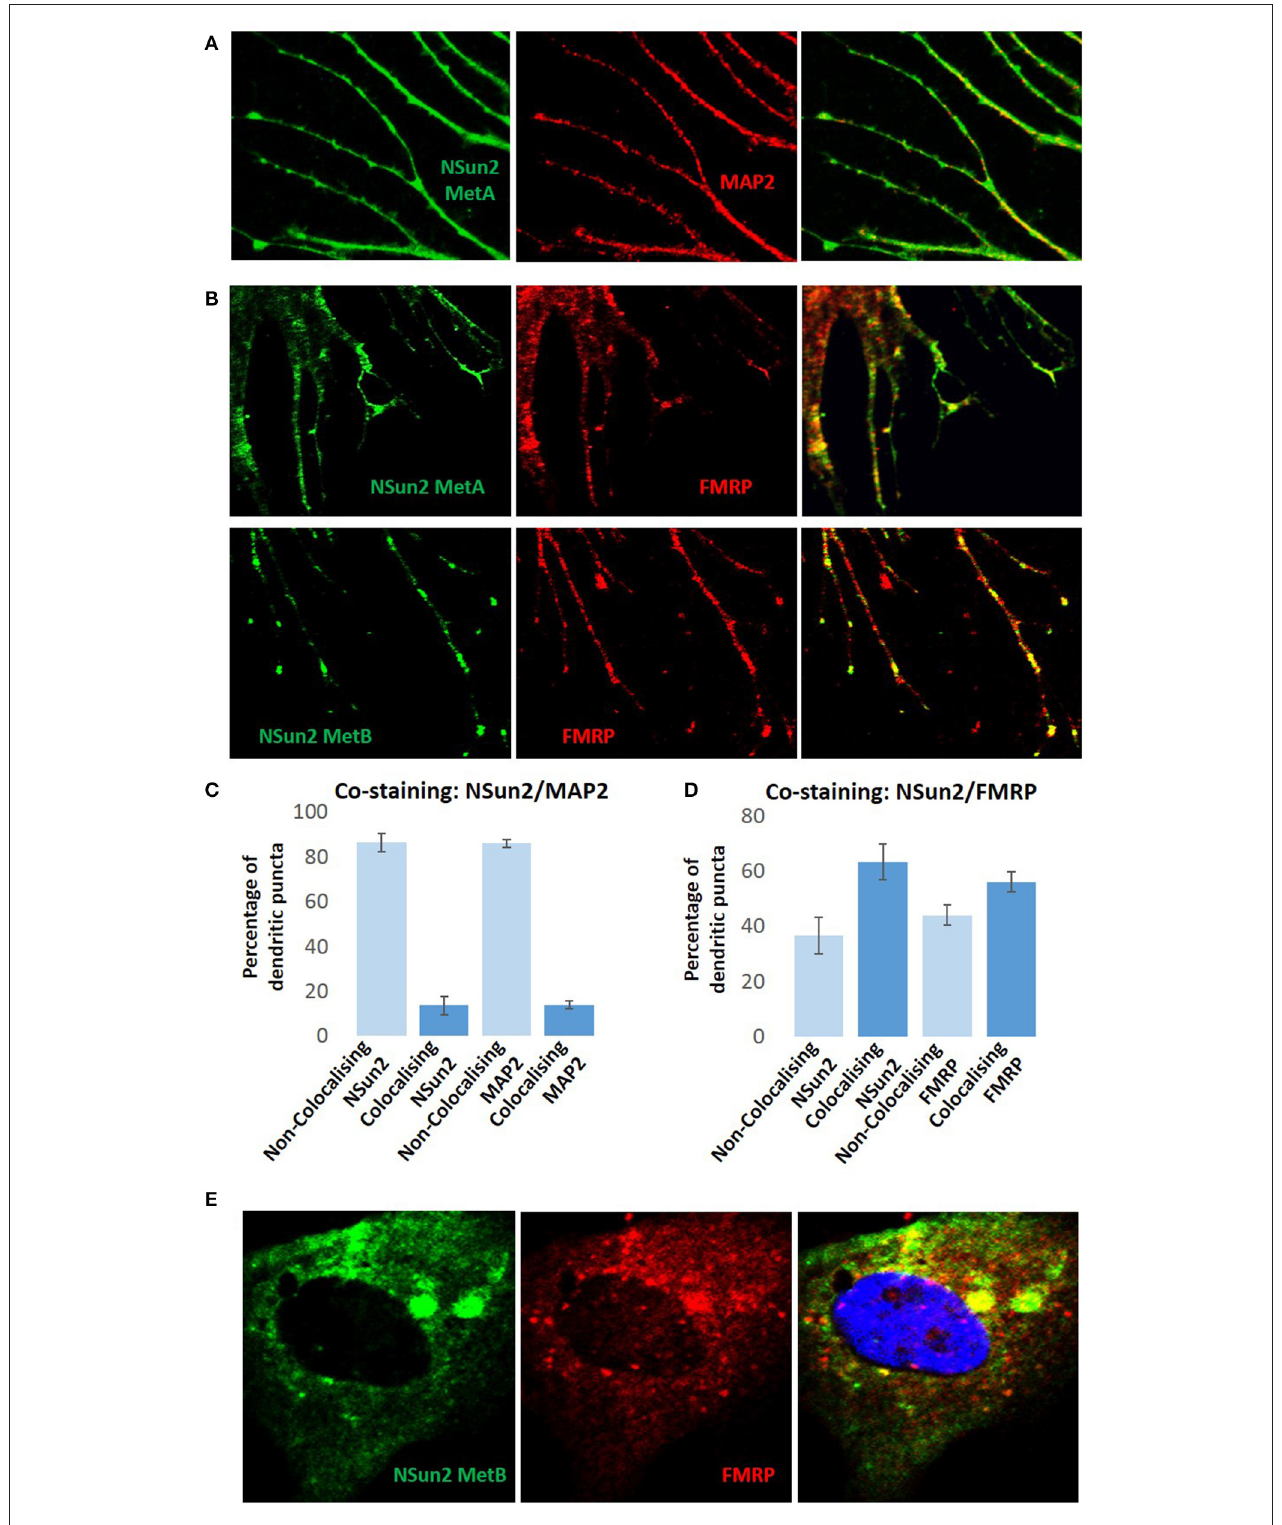
FIGURE 1 | NSun2 localizes to neuronal dendrites. The human fetal brain-derived neural stem cell line CB660 (Sun et al., 2008) was maintained in RHB-A medium (Stem Cell Sciences, UK) supplemented with FGF2 and EGF on laminin-coated culture flasks. In order to induce differentiation, the maintenance medium